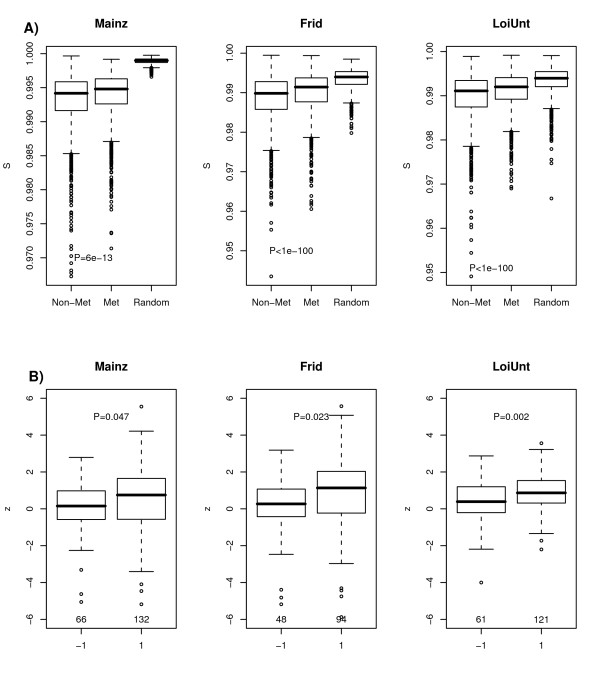
Increased entropy in metastatic breast cancer is independent of breast cancer cohort. A) Comparison of local entropies for the proteins with degrees ≥ 10 between the non-metastatic, metastatic and random weighted networks in the three validation cohorts: Mainz (1900 genes), Frid (1270 genes) and LoiUnt (1899 genes). The entropies in the metastatic network exhibit significantly higher values than those in the non-metastatic network: P-value given is from a one-tailed paired Wilcoxon rank sum test. Both non-metastatic and metastatic networks show significantly lower entropies than those of a purely random network obtained by randomisation of expression profiles. B) The top 200 genes with most significant P-values (FDR < 0.001) as identified in the EMC (discovery) data set are grouped according to increases in entropy (1) or decreases (-1). The numbers of genes within each group and represented in the validation set are given just above x-axis. The y-axis labels the statistics (dSi/σi) of these genes in the corresponding validation set, and the boxplot allows a direct comparison to be made. The P-value is from a one-tailed Wilcox rank sum test as the alternative hypothesis is that the statistics should be larger for those genes identified to undergo increases in entropy in the discovery set.